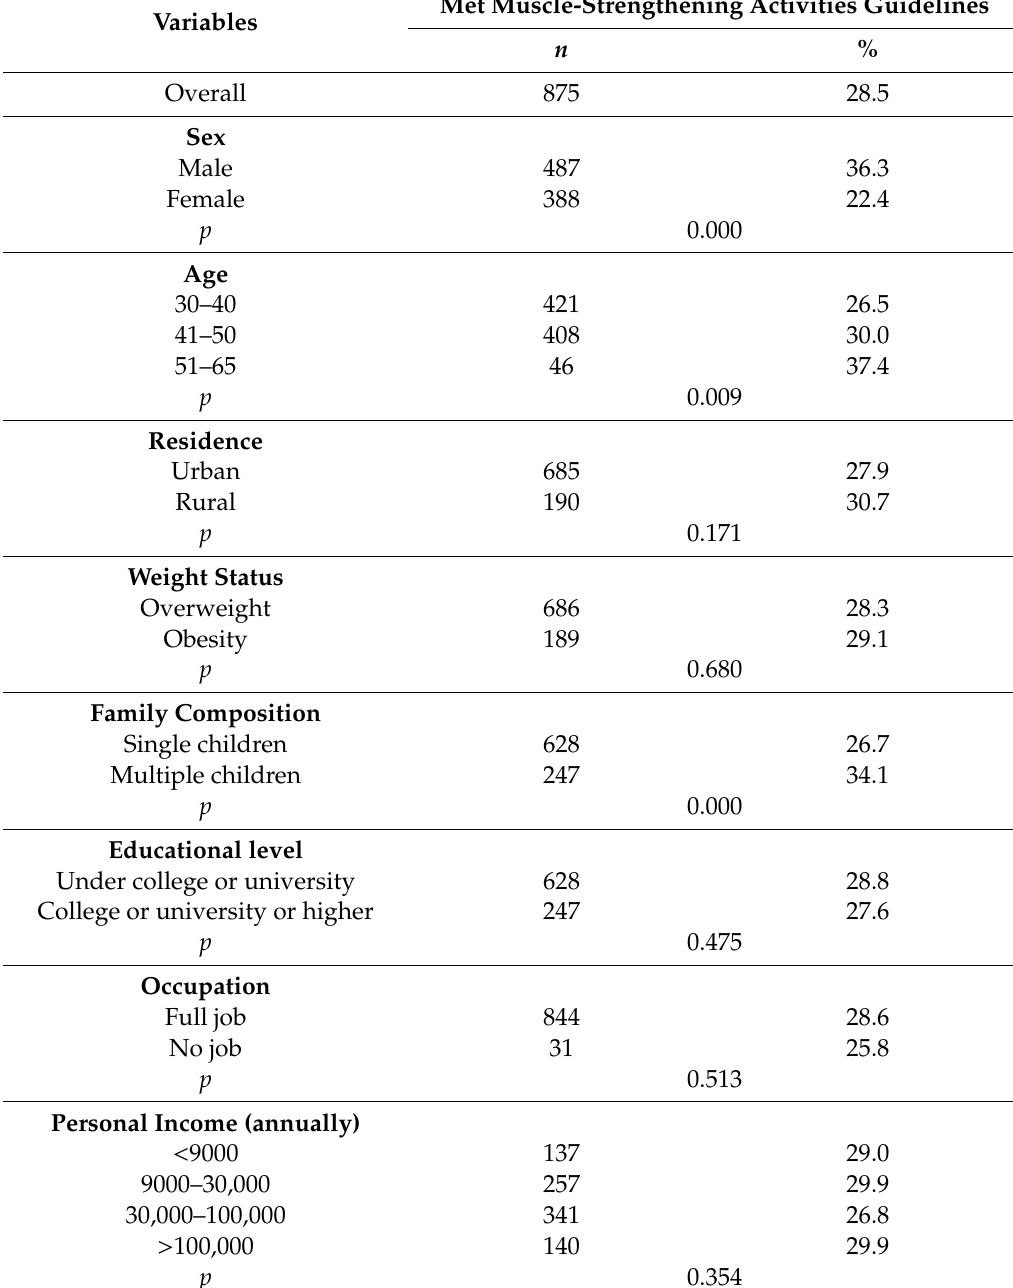
Table 1. Prevalence of meeting the muscle-strengthening (MS) activities guidelines by sociodemographic